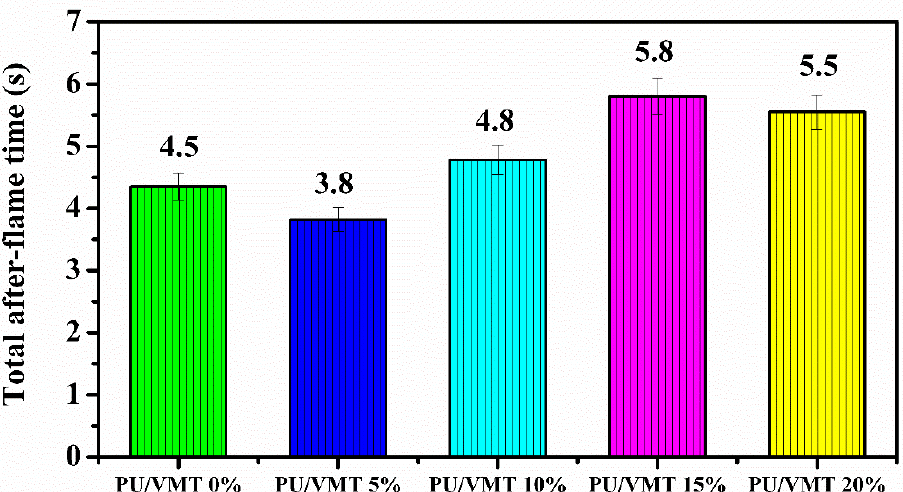
Figure 6. Flammability tests vertical.